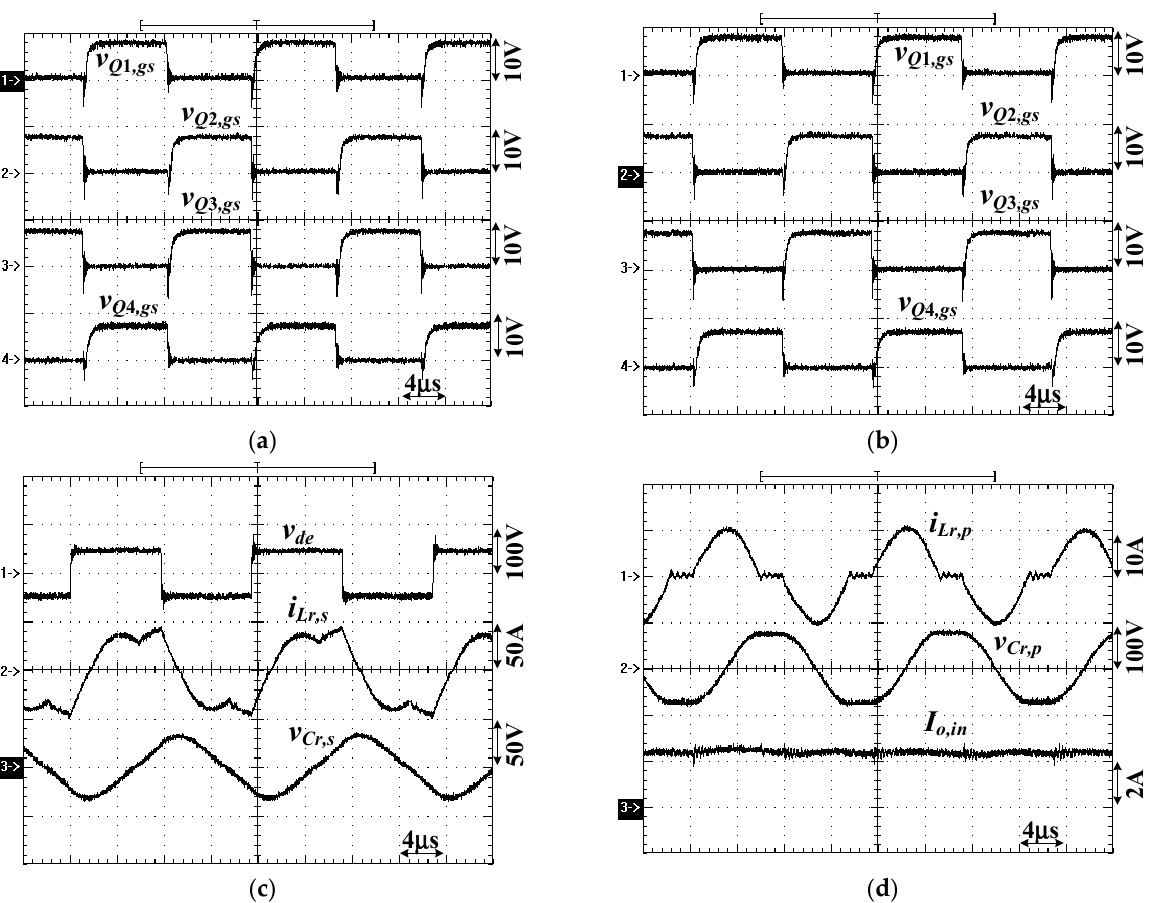
Figure 15. Measured waveforms of the proposed converter operated at reverse power flow: ( a ) Q 1 – Q 4 signals at 20% load power, ( b ) Q 1 – Q 4 signals at 100% load power, ( c ) v de , i Lr,s and v Cr,s at full rated power, ( d ) i Lr,p , v Cr,p and I o,in at full rated power.